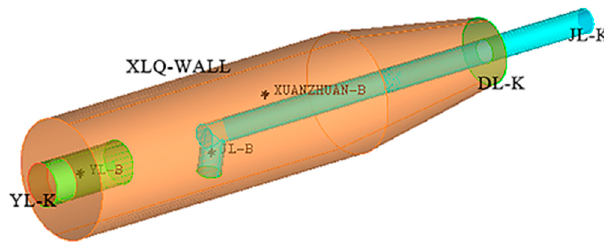
Figure 3. Three-dimensional model of the self-spinning